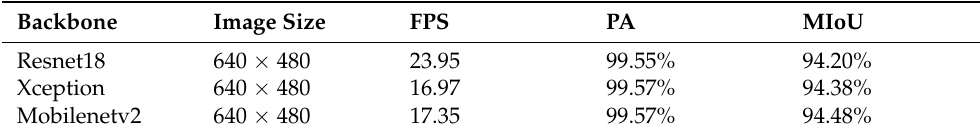
Table 5. Performance of Deeplabv3+ in different